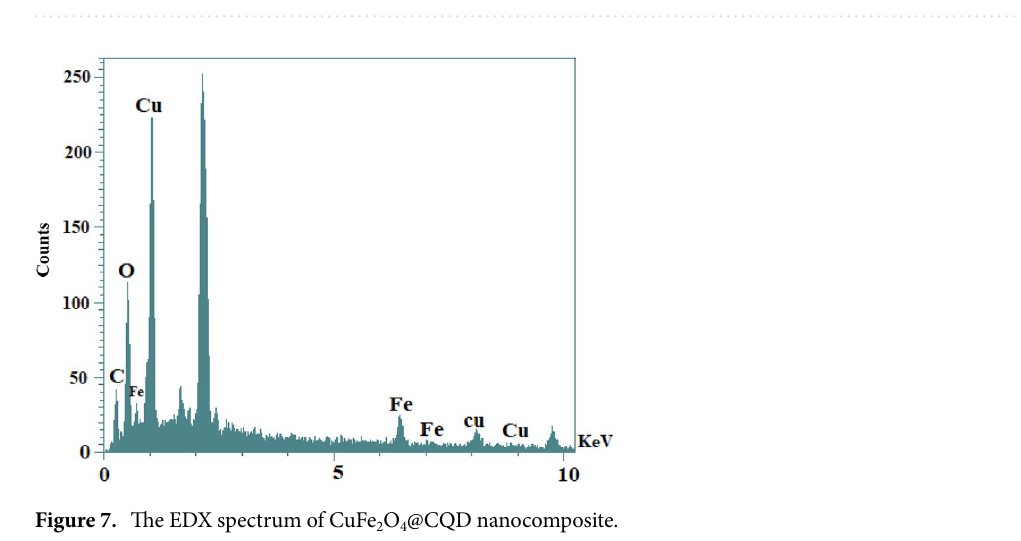
Figure 6. EDS elemental mapping of CuFe 2 O 4 @CQD nanocomposite.